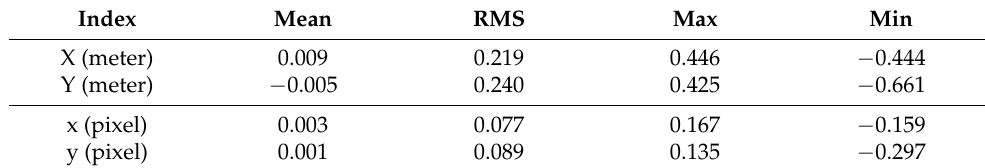
Table 6. Positioning accuracy of the corresponding image points after geometric calibration.